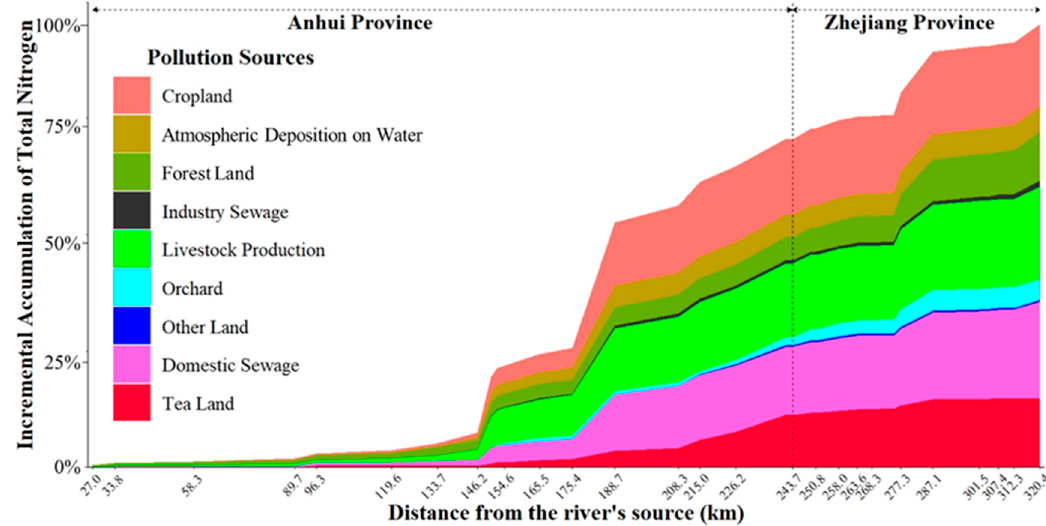
Figure 7. Average annual contributions of point and non-point sources of TN pollution along the main reach of the Xin’anjiang River.